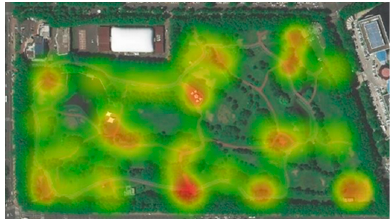
Figure 3. Residential activity distribution map.